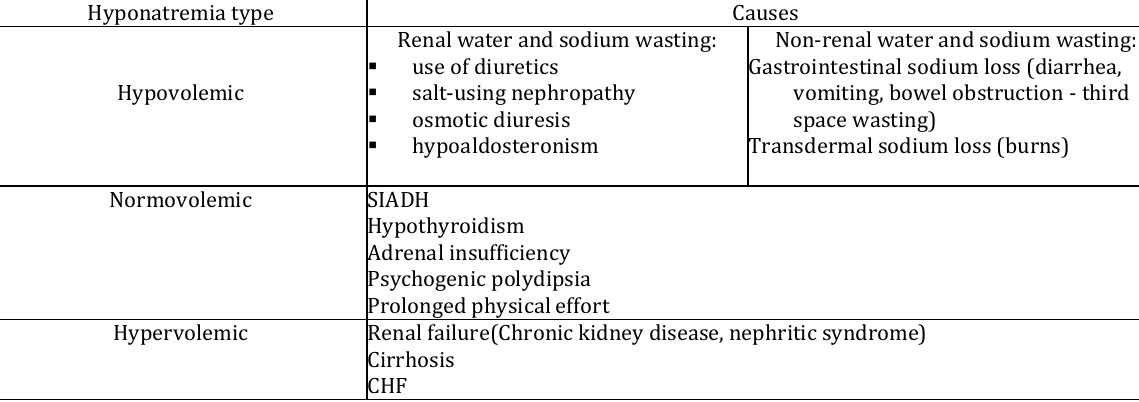
Table 3. Division of hyponatremia with regard to body fluids volume Hyponatremia